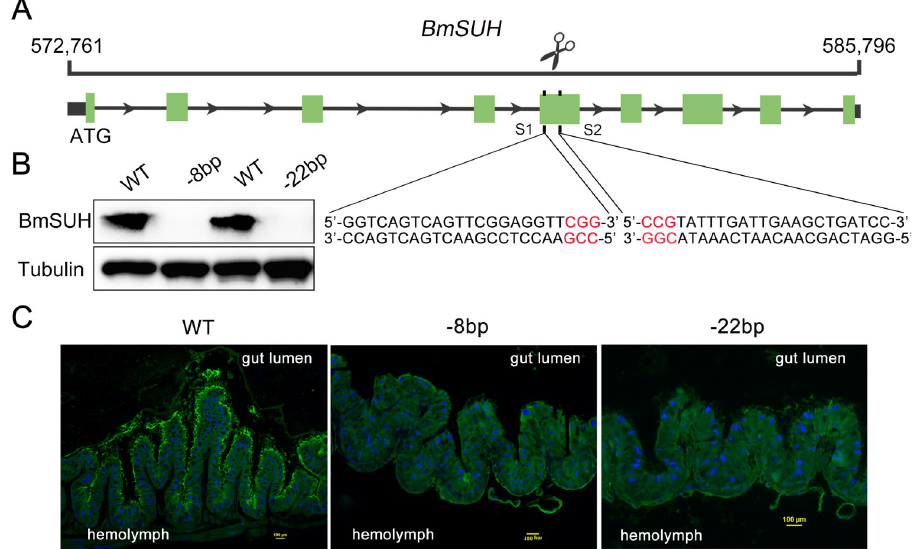
targeting sites, S1 and S2, are located on the forward strand and reverse strand of the fifth exon, respectively. The sgRNA sequences are depicted in black and the corresponding PAM sequence is marked in red. The scissors image was obtained from the “Icon Library” of iSlide application under a CC0 1.0 Universal license. Copyright: https://en. islide.cc/copyright-notice. (B) Immunoblot validation of two types of BmSUH mutants. (C) Immunofluorescence staining of BmSUH (green) on midgut tissue sections of wild-type and BmSUH deficient silkworms. Silkworm specimens were obtained from L5D3. DAPI (blue) served as a nuclear dye. WT: wild-type; -8bp and -22bp: two BmSUH mutant lines.